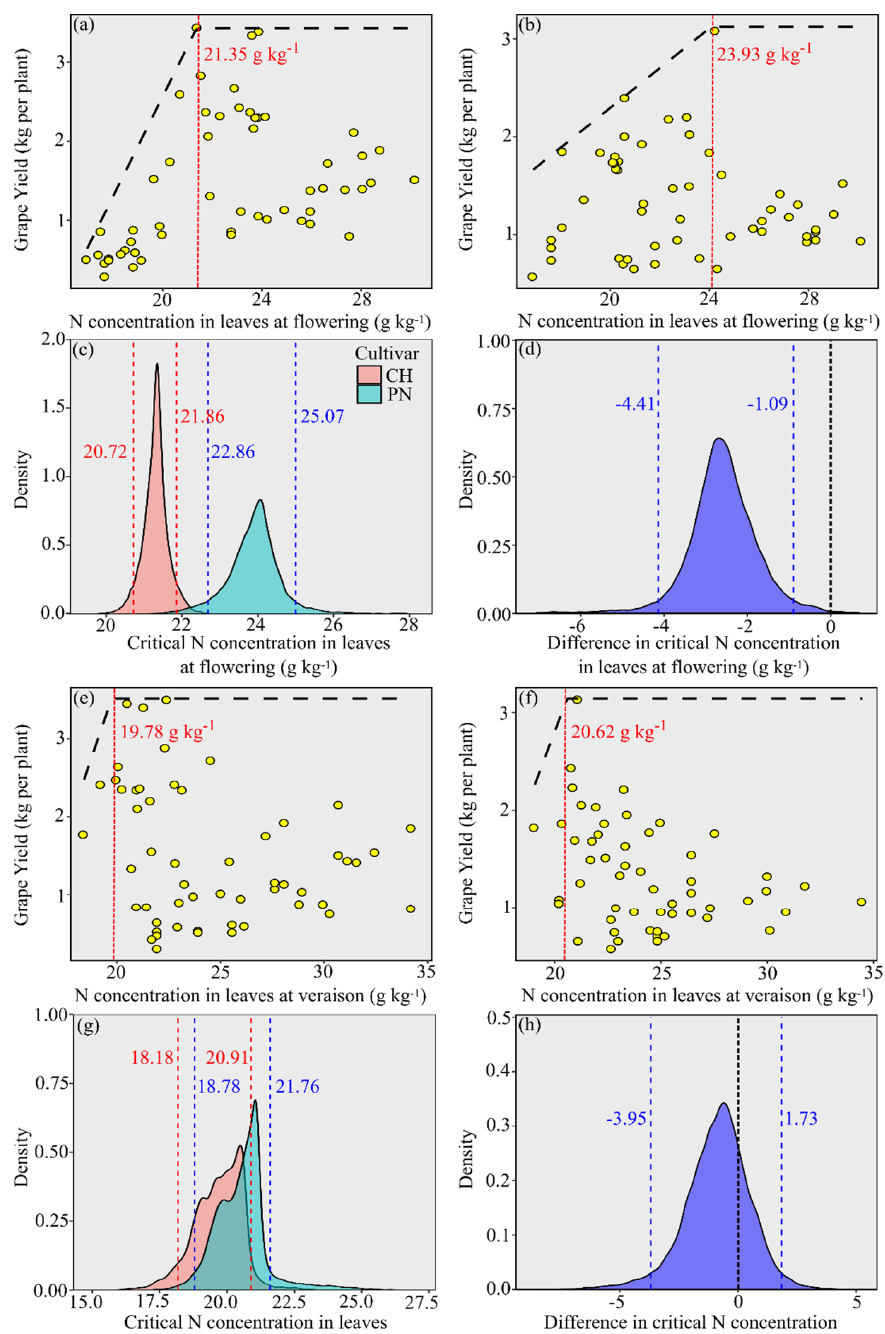
Figure 3. Nitrogen critical levels in leaves at flowering and veraison for ‘Chardonnay’ ( a , e ) and ‘Pinot Noir’ ( b , f ), respectively. Nitrogen sufficiency range in leaves at flowering ( c ) and veraison ( g ) of the grapevine cultivars. Histogram of frequency of the high-density interval of the critical N concentration in leaves at flowering ( d ) and veraison ( h ) between the ‘Chardonnay’ and ‘Pinot Noir’ cultivars subjected to N fertilization in the soil, during 2016/17, 2017/18, and 2018/19. The critical N concentration was similar between cultivars in leaves collected at veraison. N critical levels in the leaves at veraison were 19.78 g N kg − 1 (Figure 3e) and 20.62 g N kg − 1 (Figure 3f) in the cultivars ‘Chardonnay’ and ‘Pinot Noir’, respectively. The highest probability of critical N concentration occurrence at veraison, based on the density of value distributions, ranged from 18.18 to 20.91 g N kg − 1 in the cultivar ‘Chardonnay’